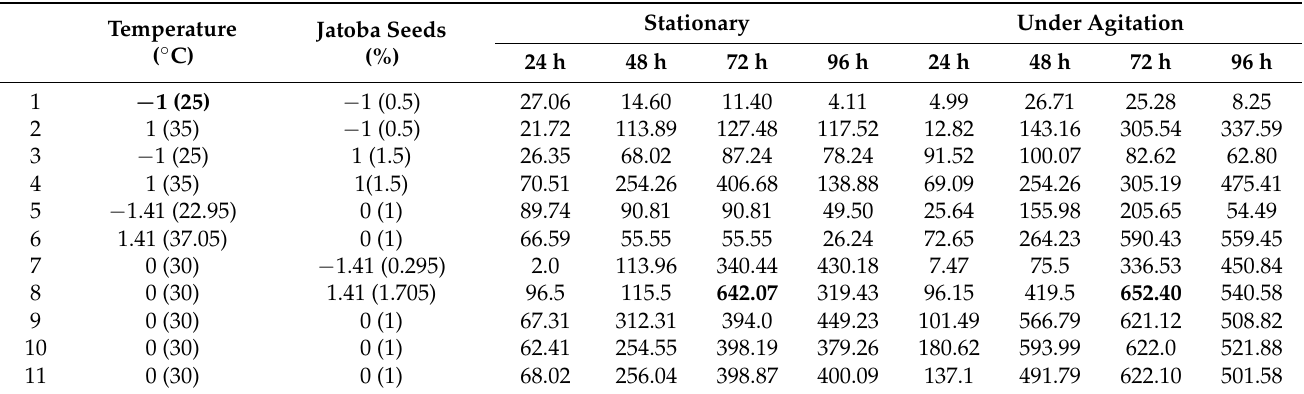
Table 3. XEG activity in the tests used for the construction of the experimental design for T. longibrachiatum cultivated with jatoba seeds.